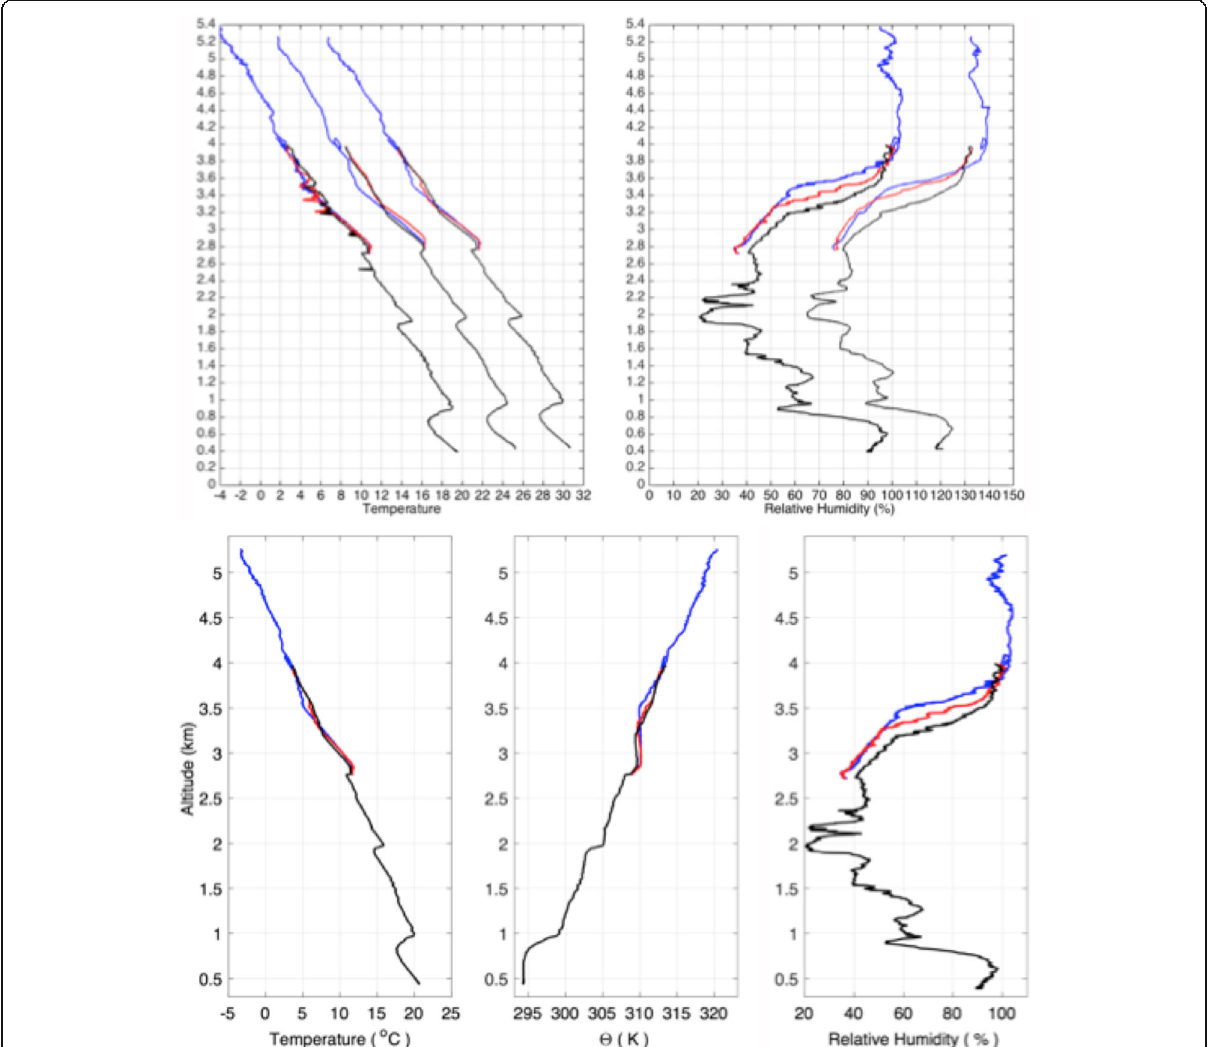
Fig. 7 The top left panel shows the temperature profiles and the top right panel , relative humidity profiles during the UAV 17 flight. The blue curve corresponds to descent D1, the red curve to ascent A2, and the black curve to descent D2. The initial ascent (A1) borne by the balloon has been omitted for clarity. Also for clarity, the profiles have been offset to the right by 5 °C for temperature and 50% for humidity. In the top left panel , the first profile refers to the iMET sensor data, with the DH profile offset to its right, which is followed by the CW profile to its right. In the top right panel , the relative humidity profile is from the iMET sensor followed to its right by that from the DH sensor. The bottom three panels show composite profiles of temperature ( bottom left ) and relative humidity ( bottom right ) from the three sets of sensors and the potential temperature derived from them ( bottom middle ). Once again, the blue curve corresponds to descent D1, the red curve to ascent A2, and the black curve to descent